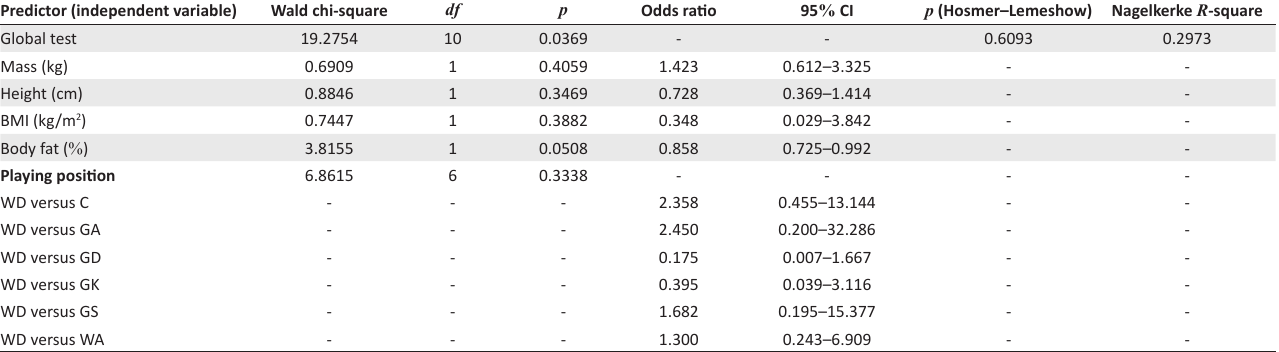
TABLE 5: Morphological variables as potential predictors of injury (multivariate logistic regression, full